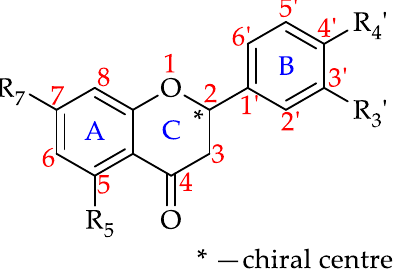
Figure 9. Basic flavanone structure (see 55 – 65 in Table 4). Table 4. Flavanones reported in monofloral honeys (see Figure 9 for general structure).